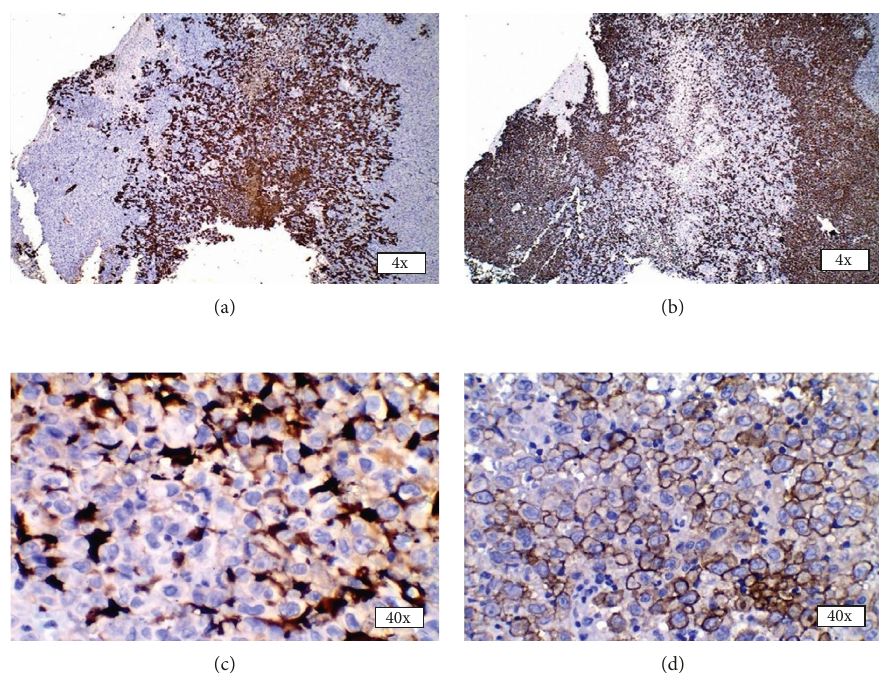
Figure 3: Immunohistochemistry. Immunohistochemical markers showing positive cytokeratin (a), vimentin (b), epithelial membrane antigen (d), and negative S100